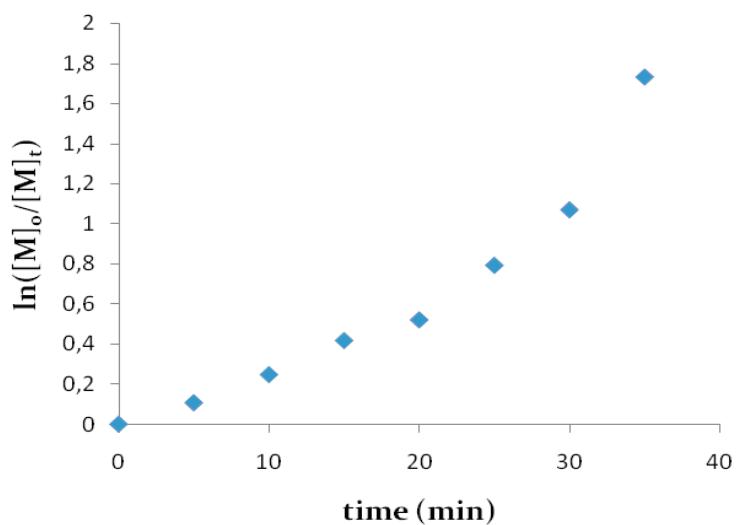
Figure 3. First-order kinetic plot for the polymerization of N -vinylcarbazole (NVK) with azobisisobutyronitrile (AIBN) in the presence of three-functional CTA